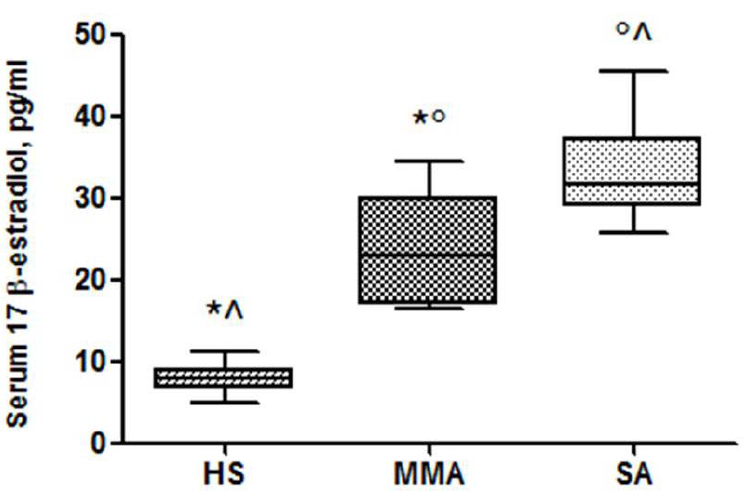
Figure 1. Serum concentrations of 17 β -estradiol in healthy subjects (HS), mild-to-moderate asthma (MMA) and severe asthma (SA) groups. * p < 0.05 HS vs. MMA, ^ p < 0.05 HS vs. SA and ° p < 0.05 MMA vs. SA.